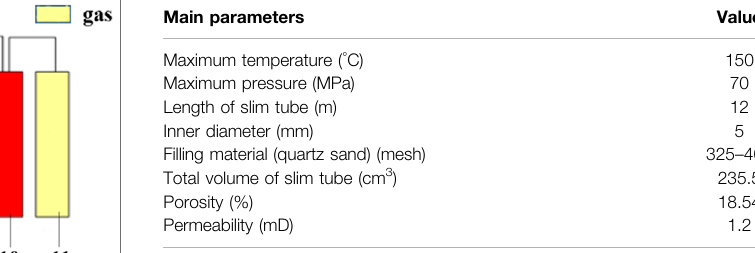
TABLE 2 | Basic parameters of slim tube